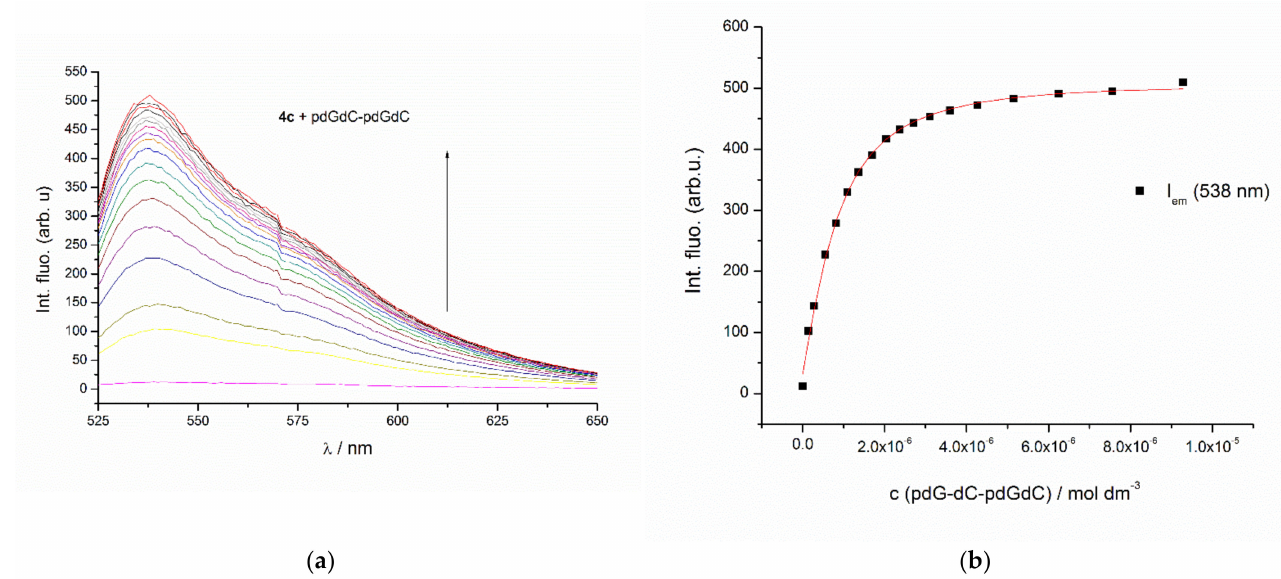
Figure 2. ( a ) Fluorimetric titration ( λ exc = 488 nm) of 4c (c = 1.3 × 10 − 7 mol dm − 3 ) with poly dGdC–poly dGdC; ( b ) Experimental ( • ) and calculated (–) fluorescence intensities of 4c at λ em = 538 nm. Table 2. Apparent stability constants (log K s ) a for fixed ratios n [bound dye]/[polynucleotide] = 0.2 a and spectroscopic properties of complexes b of 4a – 4e with ds-polynucleotides calculated according to fluorimetric titrations